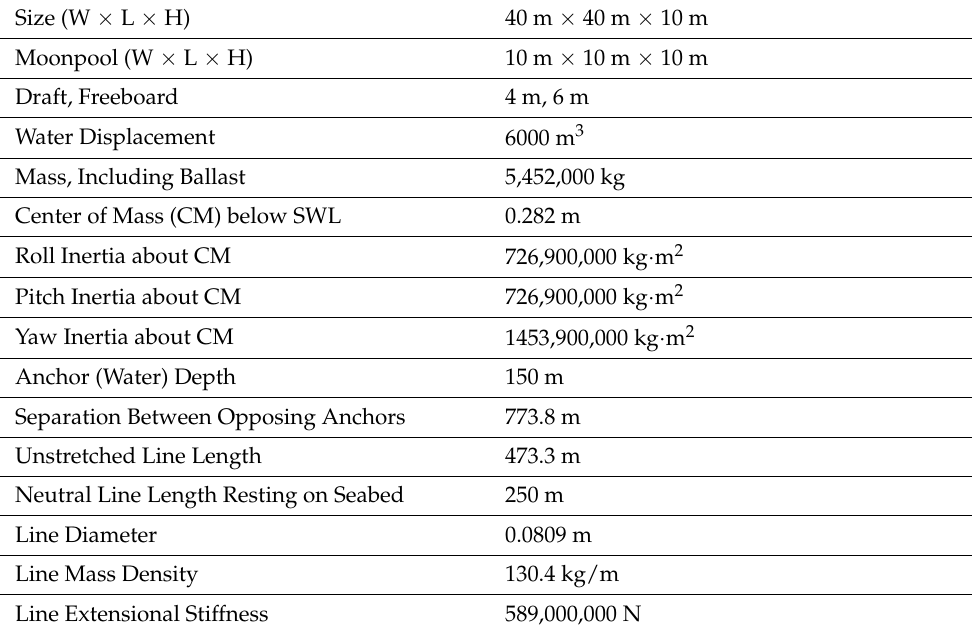
Table 2. Characteristics of the ITI Energy Barge, extracted from